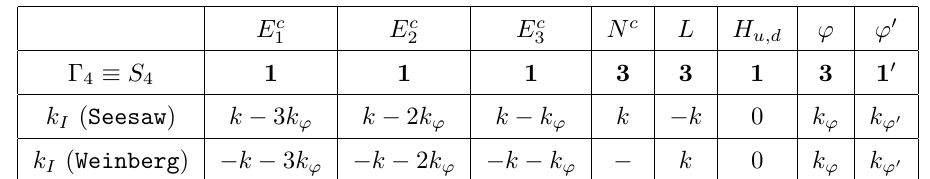
Table 1 . Chiral supermultiplets, transformation properties and weights. Weights for E c depend on whether neutrinos get their masses from the seesaw mechanism or from the Weinberg operator. A possible choice leading to the superpotential given in the text is k = (cid:0) 5 = 3, k ’ 0 = +4 = 3 and k ’ = +3 = 2. As a consequence, the neutrino sector depends only on ’ 0 and the charged lepton sector depends only on ’